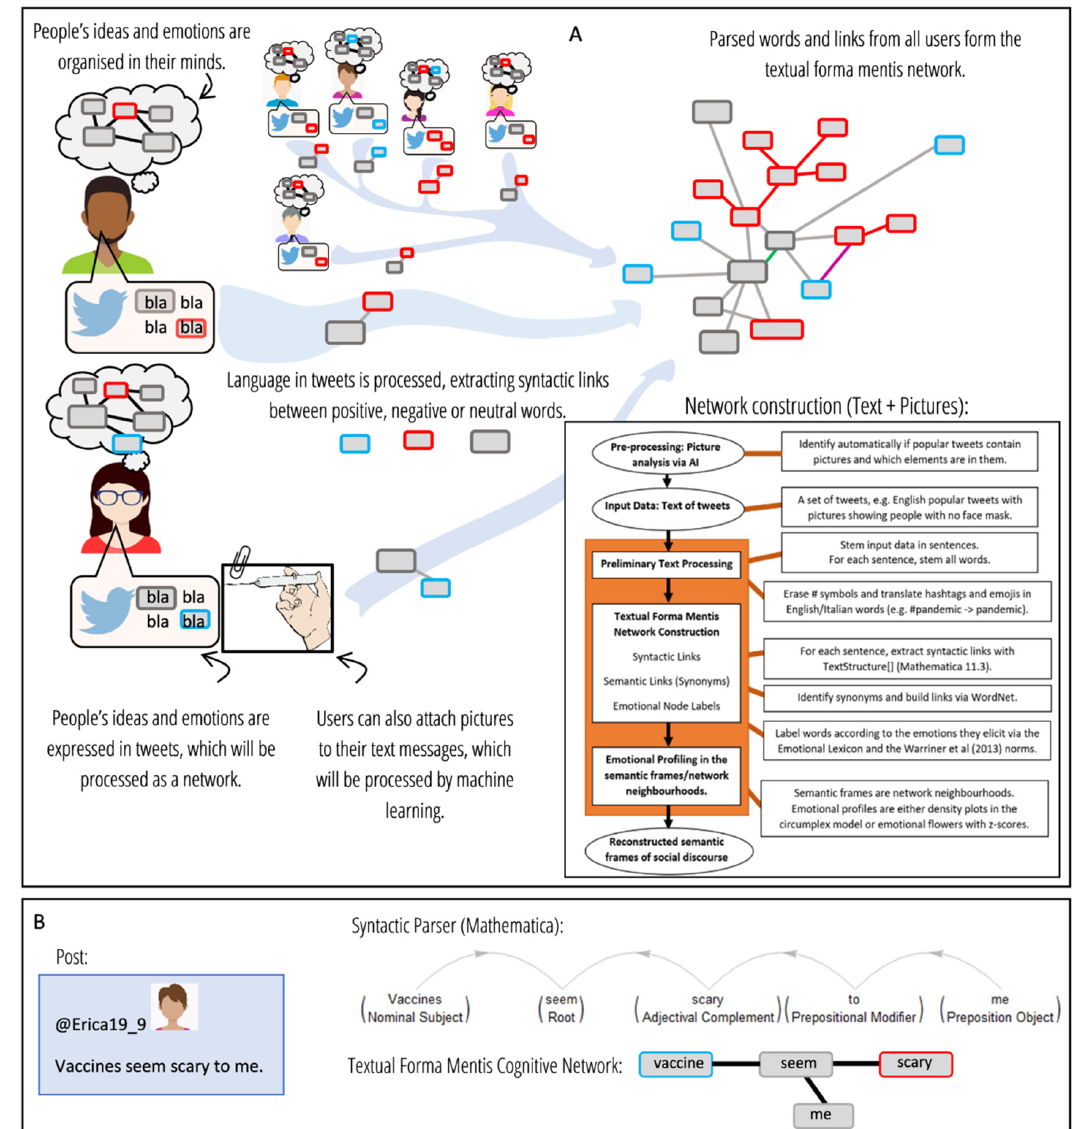
Figure 1. ( A ) Infographics about how textual forma mentis networks can give structure to the pictures and language posted by online users on social media. Semantic frames around specific ideas/concepts are reconstructed as network neighbourhoods. Word valence and emotional data make it possible to check how concepts were framed by users in posts mentioning (or not) pictures showing specific elements (e.g., people wearing a face mask). A flowchart with the different steps of network construction is outlined too. ( B ) Example tweet being processed.